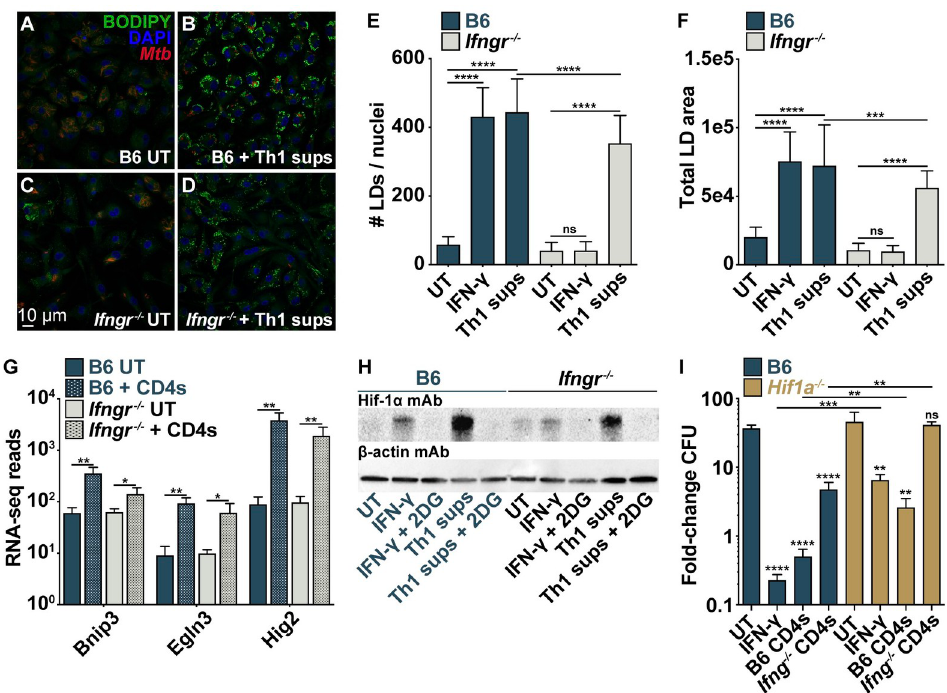
Fig 4. IFN- γ -independent control requires the transcription factor HIF-1 α . ( A )-( D ) Microscopy for host lipid droplets (LDs) at d 3 postinfection for wild-type and Ifngr -/- BMDMs treated with Th1 supernatants (sups). ( E )-( F ) Quantification of (A)-(D) for (E) average number of LDs per BMDM and (F) total LD area. ( G ) RNA-seq reads of HIF- 1 α target genes. ( H ) Western blot for HIF-1 α on cell lysates 12 h postinfection for wild-type and Ifngr -/- BMDMs treated with Th1 sups and 2-DG. ( I ) CFU fold-change at d 5 postinfection for wild-type and Hif1a -/- BMDMs co- cultured with wild-type or Ifng -/- lung-derived CD4 T cells. Figures represent data from four replicate experiments (G) or are representative of two (H) or three (A)-(F), (I) independent experiments. Error bars are SD from four independent experiments (G), four replicate samples (I), or 48 images from four replicate wells (E)-(F) � p < 0.05, �� p < 0.01, ��� p < 0.001, ���� p < 0.0001 by unpaired t-test; p-values above bars are relative to UT for each